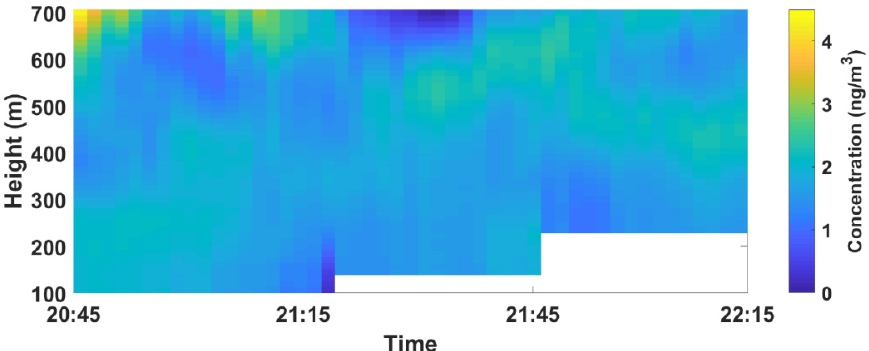
Figure 4. Vertical monitoring of mercury concentrations at the second measurement site 2. Clear and varying concentration structures could be observed, while aerosols exhibited little structure. The wind direction was from south to east.